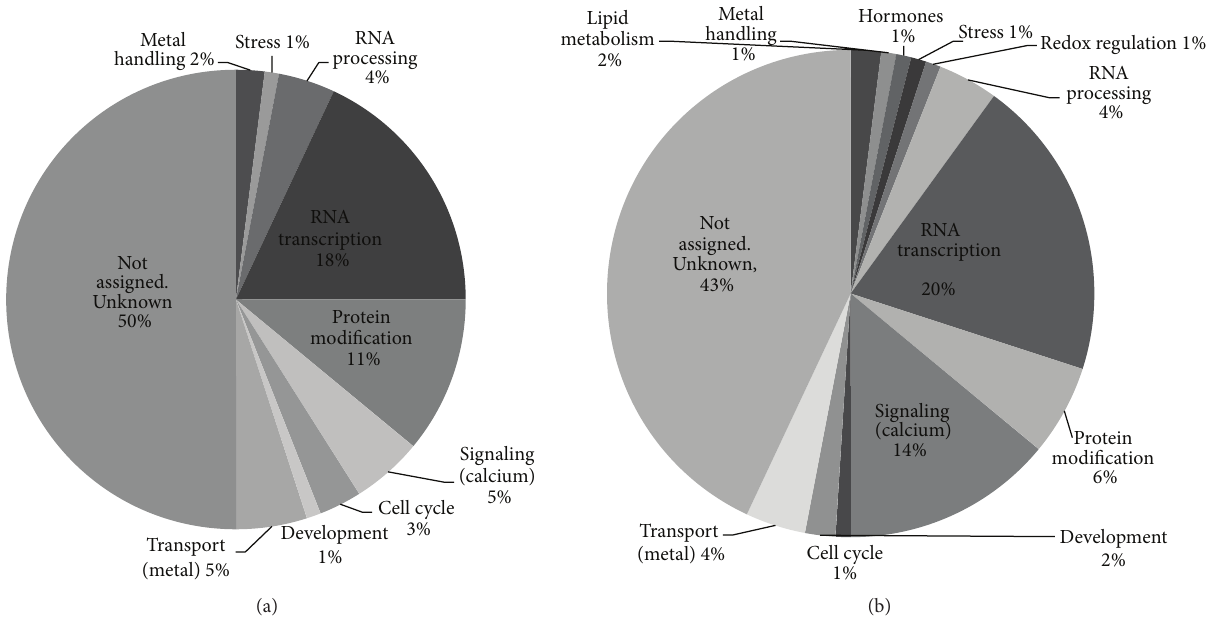
Figure 1: Distribution of genes encoding MRPs into various biological processes in Arabidopsis (a) and soybean (b).